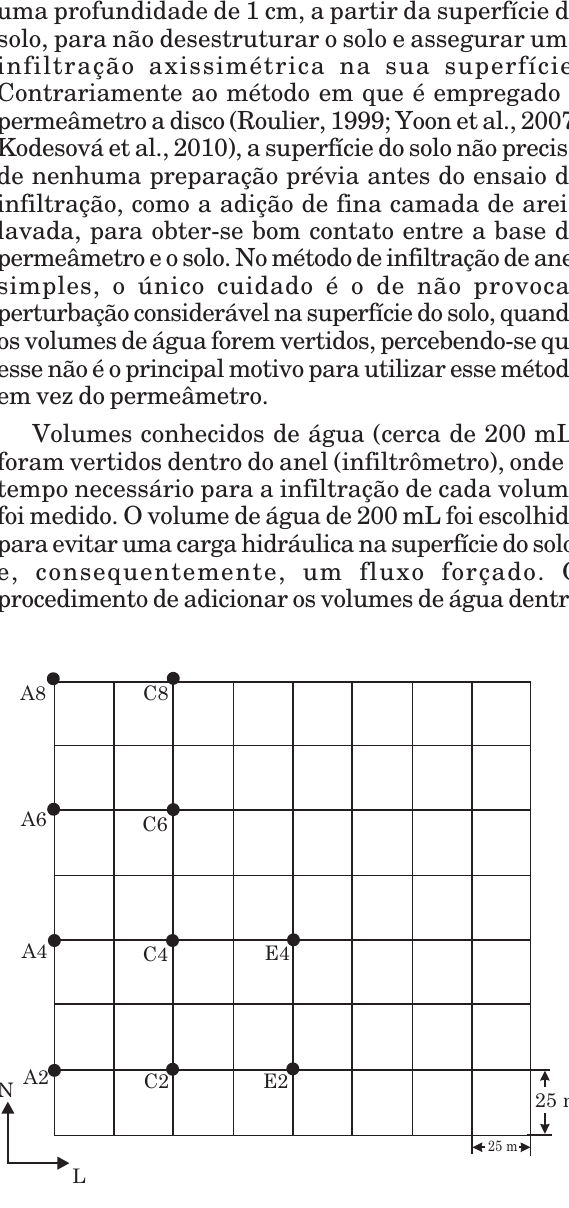
Figura 1. Localização dos pontos experimentais na área em estudo. Nos pontos destacados com letras e números, realizaram-se os ensaios de infiltração com água e